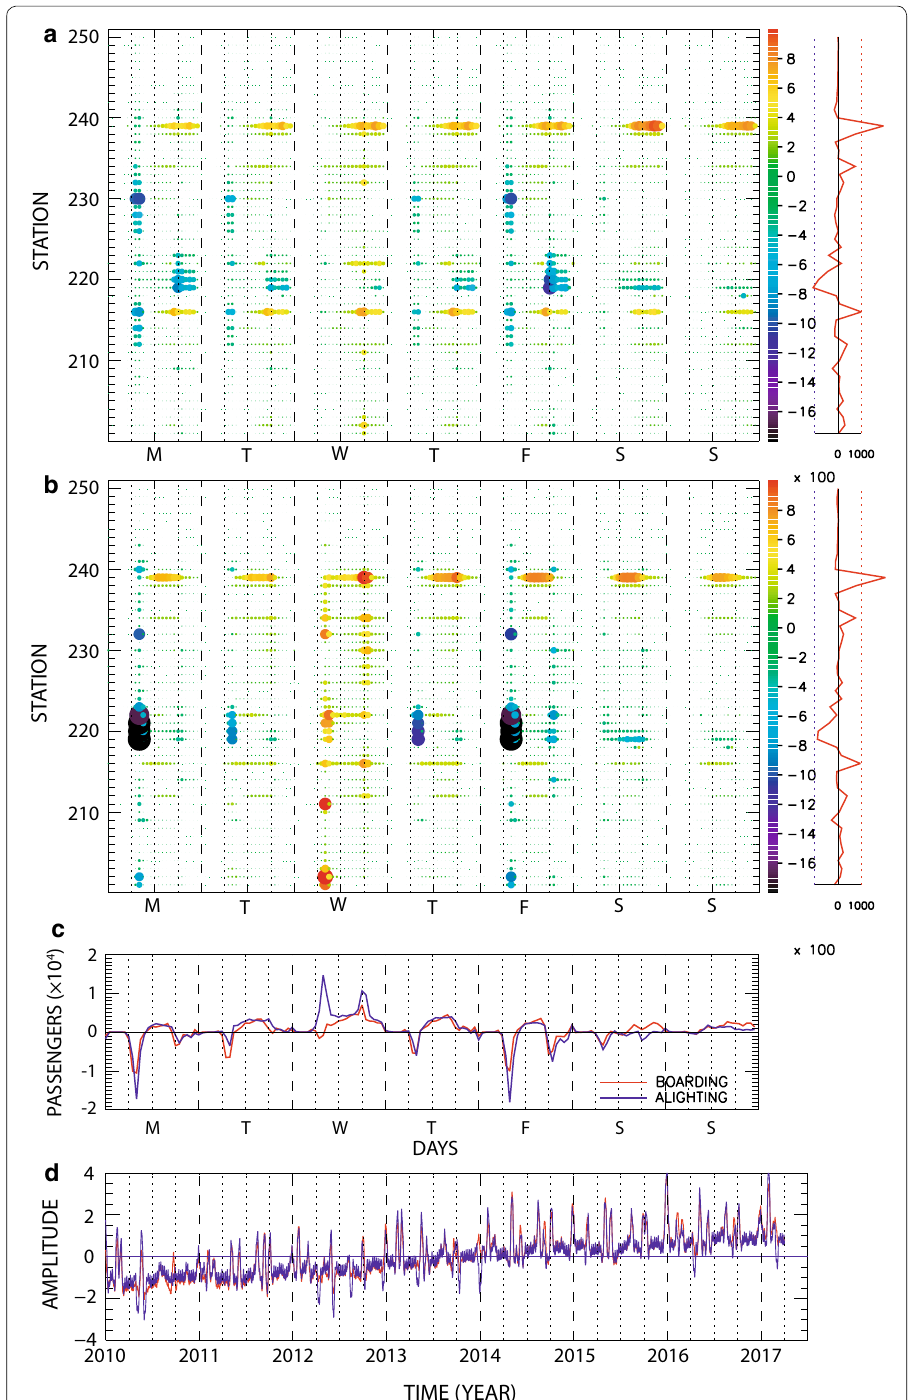
Fig. 9 The fourth mode of CSEOF representing the weekly patterns of passengers for Subway Line #2: a hourly and total number of boarding passengers at each of the 50 subway stations numbered from 201 to 250; b hourly and total number of alighting passengers; c number of boarding (red) and alighting passengers in all stations; and d corresponding amplitude time series. There are two major clusters and several distinct locations such as Station 239 and stations nearby Station 220 are surfaced in this mode throughout the